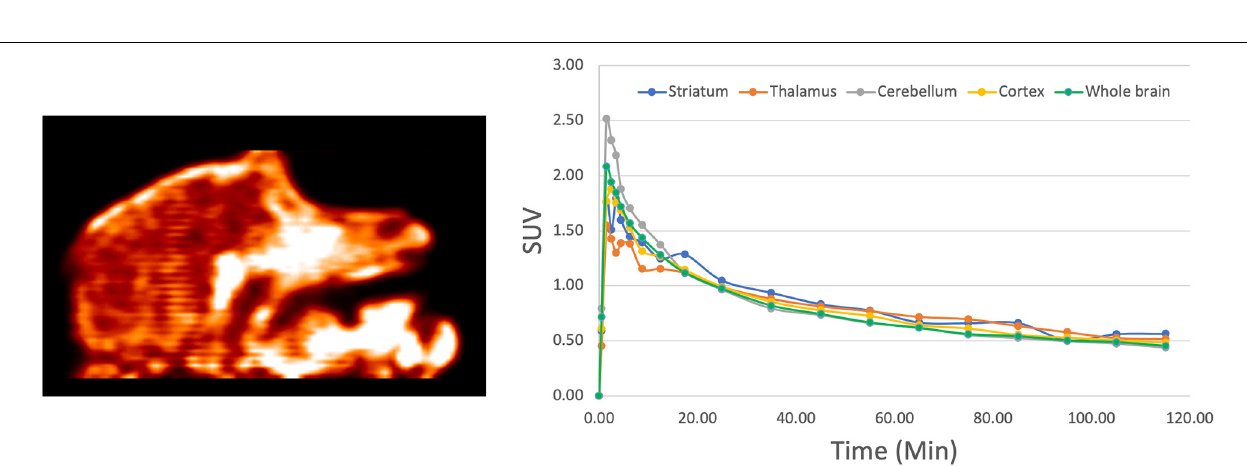
Frontiers in Neuroscience |